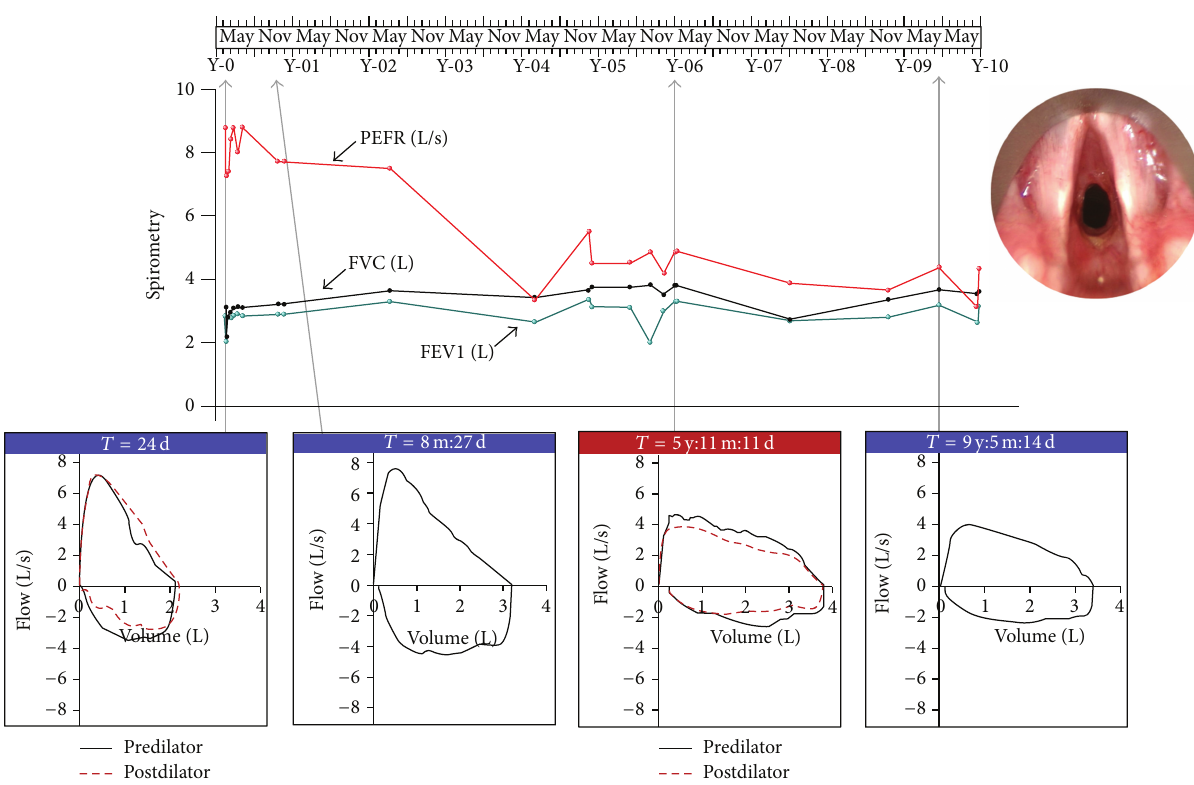
Figure 1: Investigations during the period of mistaken diagnosis. Spirometry and flow-volume loops taken over a ten-year period from initial presentation through to emergency laser resection of the patient’s stenosis. The inset image is that of the patient’s larynx via an endoscope at the time of her first surgery and shows a Myer-Cotton grade 2 (51–70%) mature fibrotic subglottic